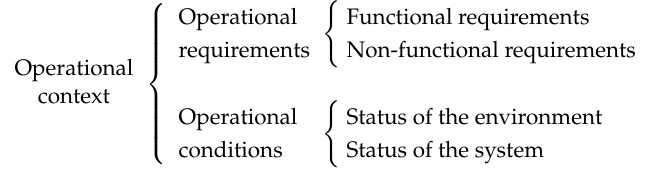
Figure 1. Components of the operational